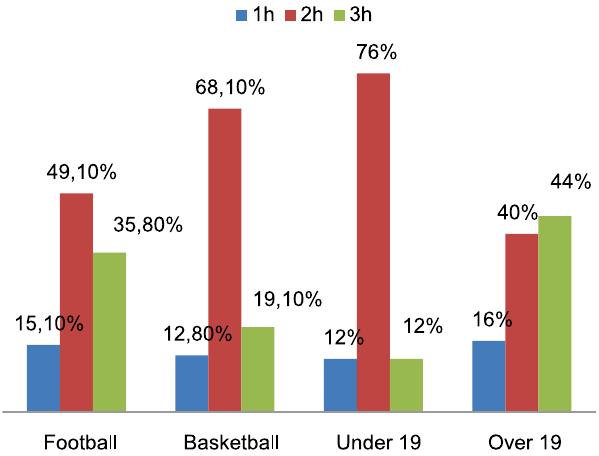
FIGURE 1. test resultson awareness of sportsmen per type of sport and age